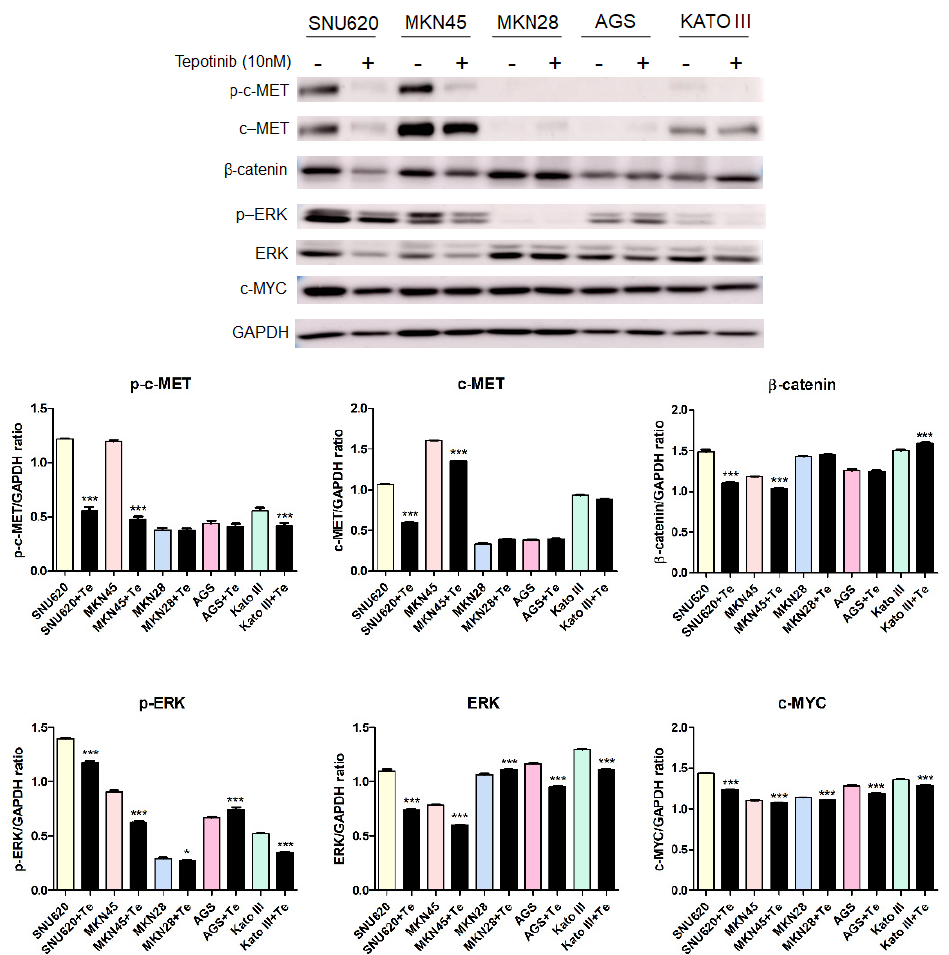
Figure 5. The effect of tepotinib on c-MET, β -catenin, ERK, and c-MYC protein levels in GC cells. The protein levels of phosphorylated and total c-MET, β -catenin, phosphorylated and total ERK, and c-MYC in MKN45, SNU620, MKN28, KATO III, and AGS cells were determined by Western blot analyses after treatment with tepotinib (10 nM) for 48 h. Data represent the means ± SD. Significance was evaluated by one-way ANOVA; * P < 0.05; *** P <